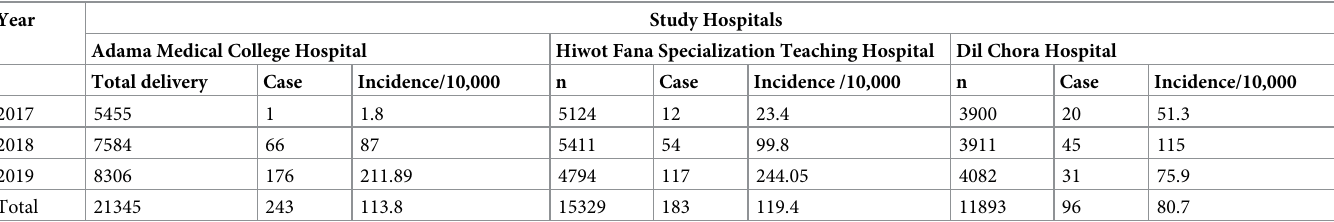
Table 6. Linear trend of NTD incidence among study hospitals Eastern Ethiopia, data from September 2017–2019.